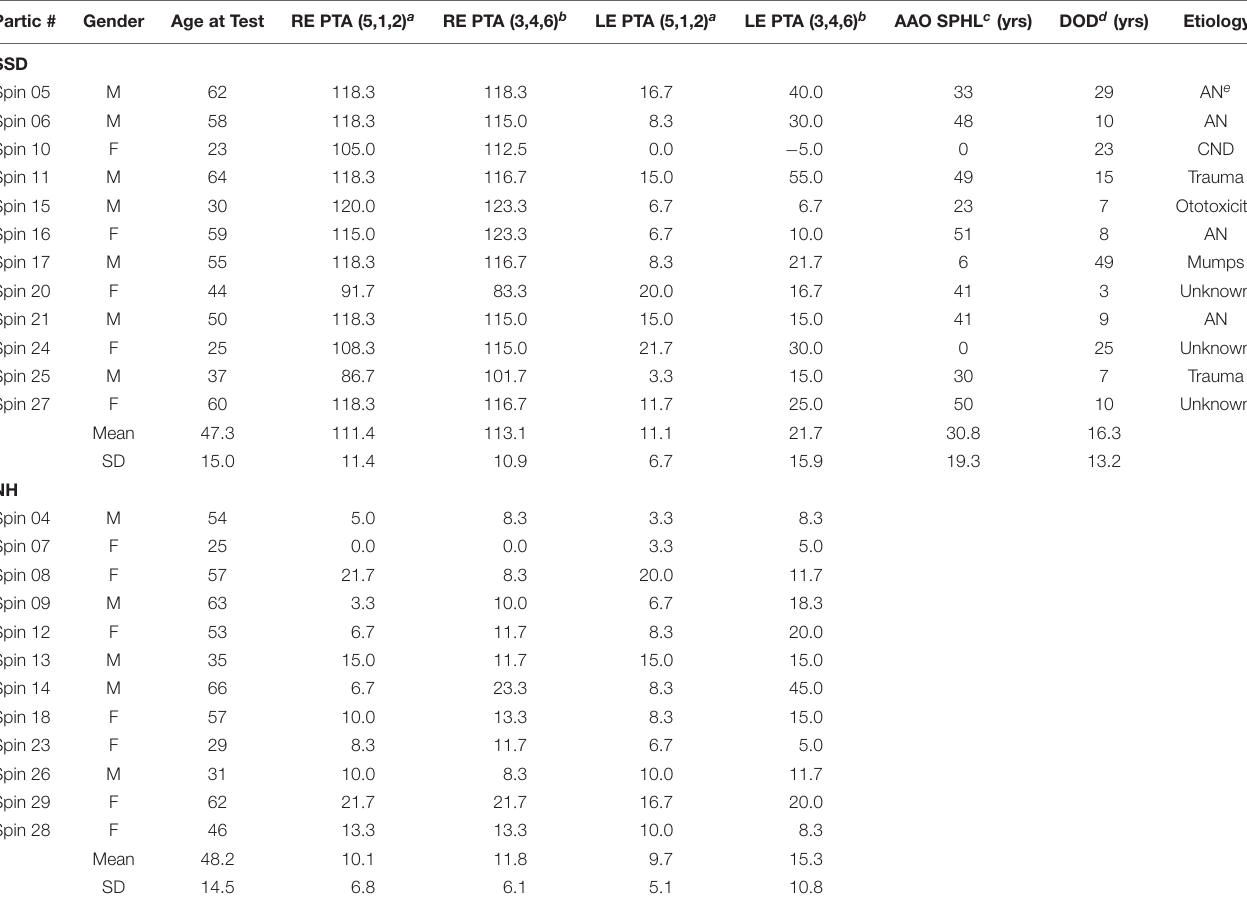
TABLE 1 | Demographics and pure tone average thresholds for SSD and NH